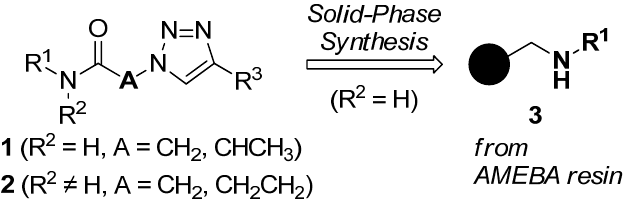
Figure 1. Structure and use of 1,2,3-triazoloamides 1 and 2 .